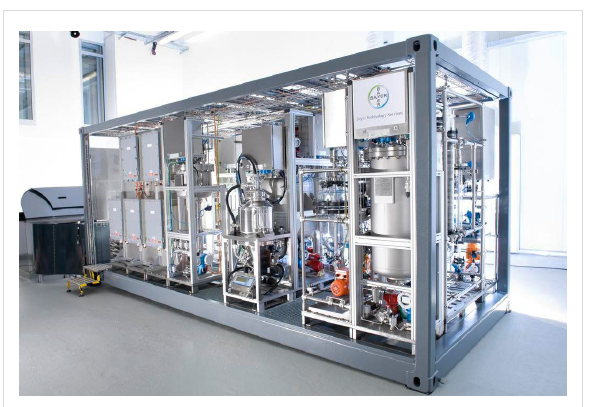
Figure 4: Container sized portable mini factory (photograph credit: INVITE GmbH, Leverkusen